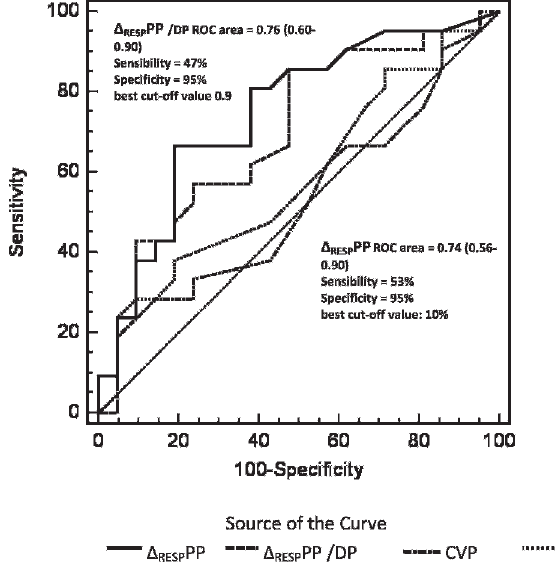
Figure 1 - Receiver operating characteristic (ROC) curves comparing pulse pressure variation ( D RESP PP), D RESP PP adjusted to driving pressure ( D RESP PP/DP), central venous pressure (ROC area: 0.57 [0.38-0.76]) and pulmonary artery occlusion pressure (ROC area 0.51 [0.32-0.70]) to determine patient responses to volume expansion. The area under the curve for D RESP PP or D RESP PP/DP is greater than that for the central venous pressure (CVP) or pulmonary artery occlusion pressure (PAOP). PPV: positive predictive value; NPV: negative predictive value; LR + : positive likelihood ratio; LR: negative likelihood